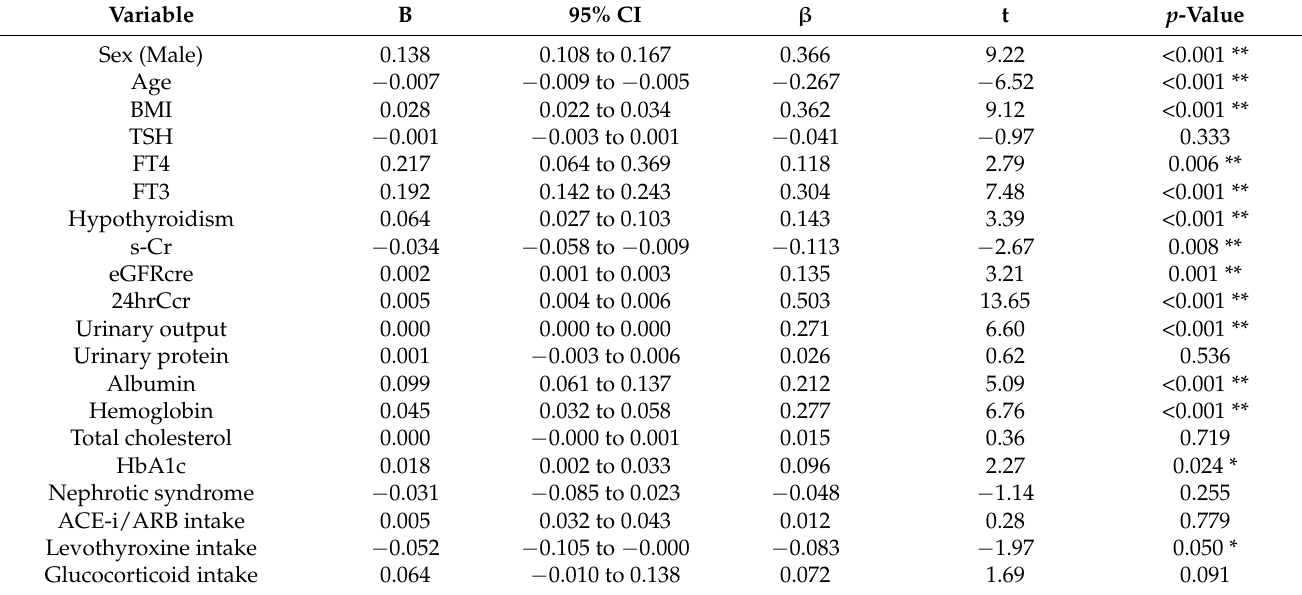
Table 3. Univariate regression analysis of urinary creatinine excretion rate and